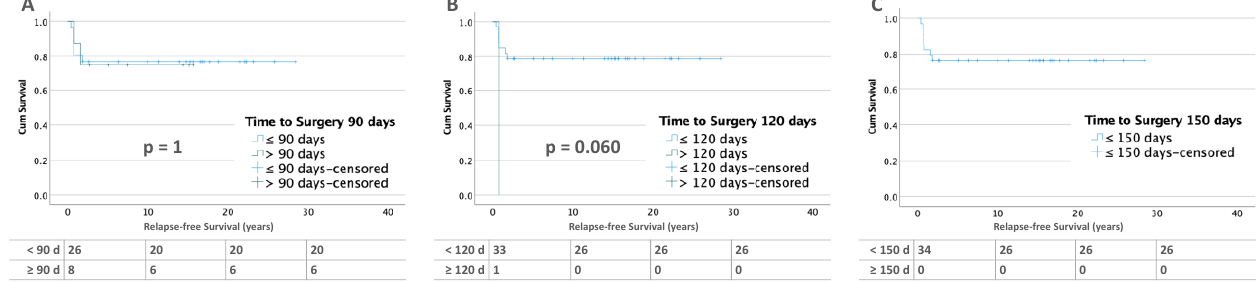
Figure 5. Kaplan – Meier lifetables of RFS of bilateral WT with metastases at diagnosis at thresholds of 90 ( A ), 120 ( B ), and 150 ( C ) days of preoperative chemotherapy. No patient underwent surgery after 150 days, so lifetable C shows only the <150-days group. In the tables below the figures, the numbers at risk are reported.